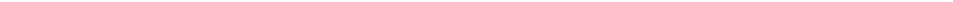
Fig. 3 Spatio-temporal dynamics of SHP2 oxidation. a Serum-starved Swiss 3T3 cells were stimulated with PDGF-BB (50 ng ml − 1 ) for the indicated times, and subjected to dimedone-PLA. Representative images are shown for each condition from one of two independent experiments. The graph shows the average number of PLA signals per cell ( n = 6 images for each condition, 5 – 20 cells in an image), relative to unstimulated control cells (normalized to 1). Scale bar : 50 μ m. b Serum-starved Swiss 3T3 cells were stimulated with PDGF-BB (50 ng ml − 1 ) for the indicated times. Dimedone-PLA ( magenta ) and co-staining with the indicated markers ( green ) are shown. Nuclei were stained with DAPI ( blue ). Representative images are shown for each condition from one of three independent experiments. Higher magni fi cation images of the boxed regions are shown. Median distances of centers of mass ( CM ) between punctate signals of ox-SHP2 and the nearest indicated marker signal in cells were obtained by object-based image analysis. The box-whisker plots show the median inter-object distances at the indicated times after stimulation ( n = 50 cells, each time point). Boxes indicate the 25th – 75th percentile; whiskers represent the 5th – 95th percentile. *** P < 0.0001, ANOVA with Bonferroni/Dunn ’ s post-hoc test. Scale bar : 10 μ m. c Serum-starved Swiss 3T3 cells